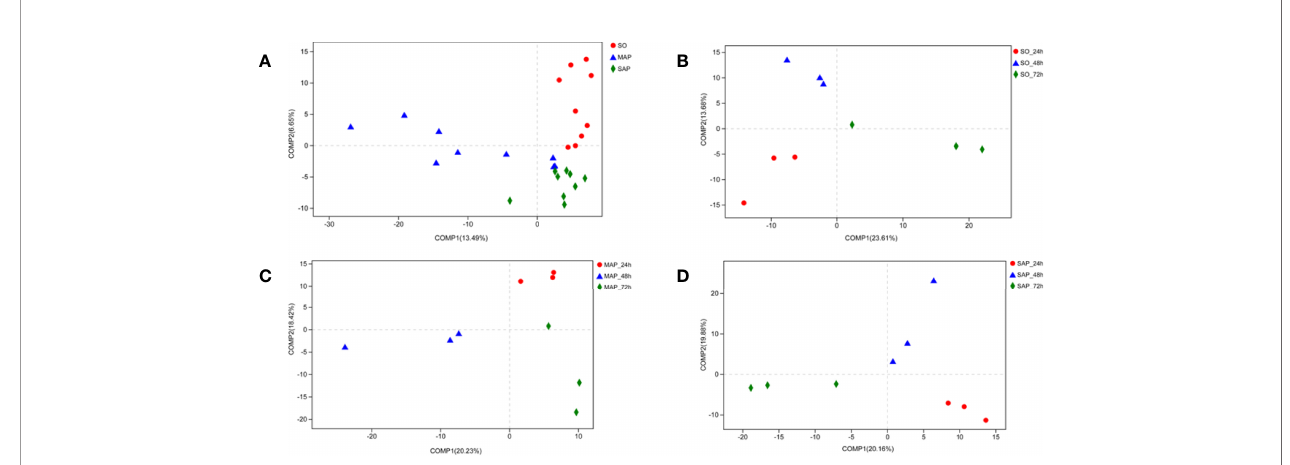
FIGURE 4 | Bacterial community beta-diversity by PLS-DA analyses in fecal samples. (A) The different colors in the PLS-DA analysis represent different groups. (B – D) PLS-DA analysis demonstrates the difference in the same group at three time points for fecal samples of SO, MAP, and SAP rats. SO, Sham operation; MAP, Mild acute pancreatitis and SAP, Severe acute pancreatitis; PLS-DA, partial least squares discriminant analysis.